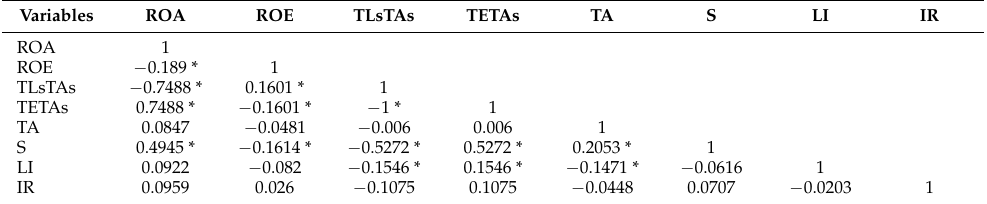
Table 2. Correlation among the Variables.